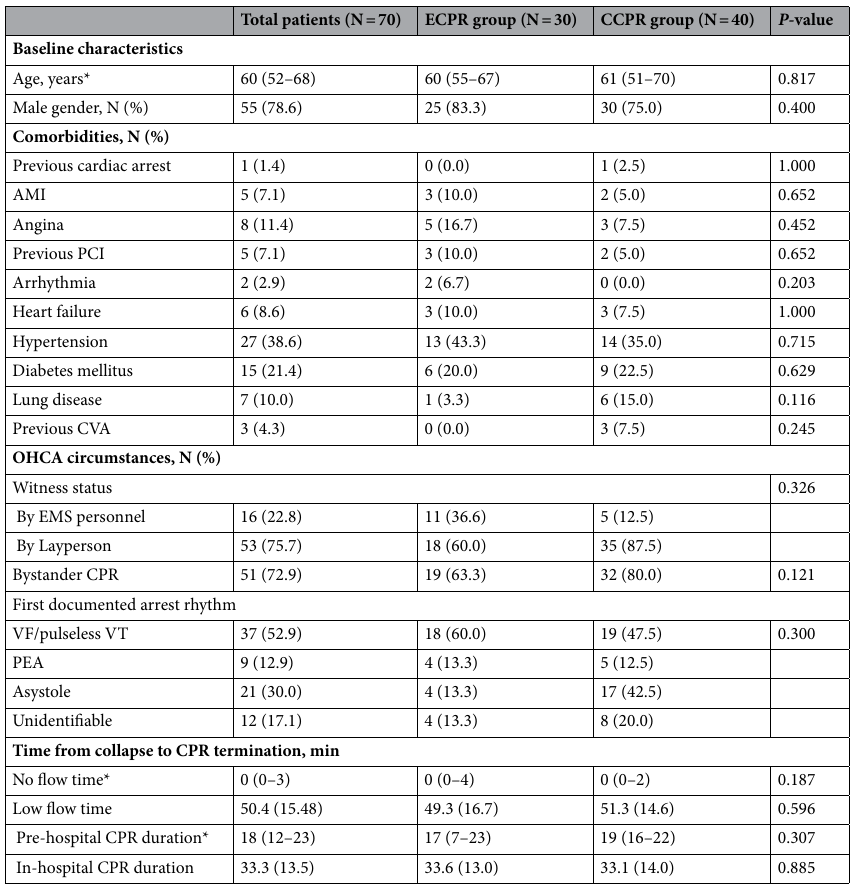
Table 1. Characteristics of patients who met the inclusion criteria. ECPR extracorporeal cardiopulmonary resuscitation, CCPR conventional cardiopulmonary resuscitation, AMI acute myocardial infarction, PCI percutaneous coronary intervention, CVA cerebrovascular accident, OHCA out-of-hospital cardiac arrest, CPR cardiopulmonary resuscitation, EMS emergency medical services, VF ventricular fibrillation, VT ventricular tachycardia, PEA pulseless electric activity, CPC cerebral performance category. *Median (IQR).